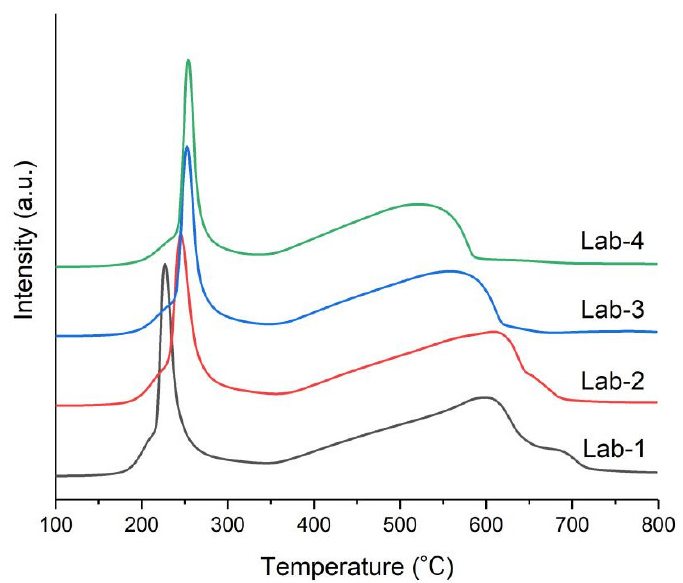
Figure 3. Temperature programmed reduction profiles of the calcined